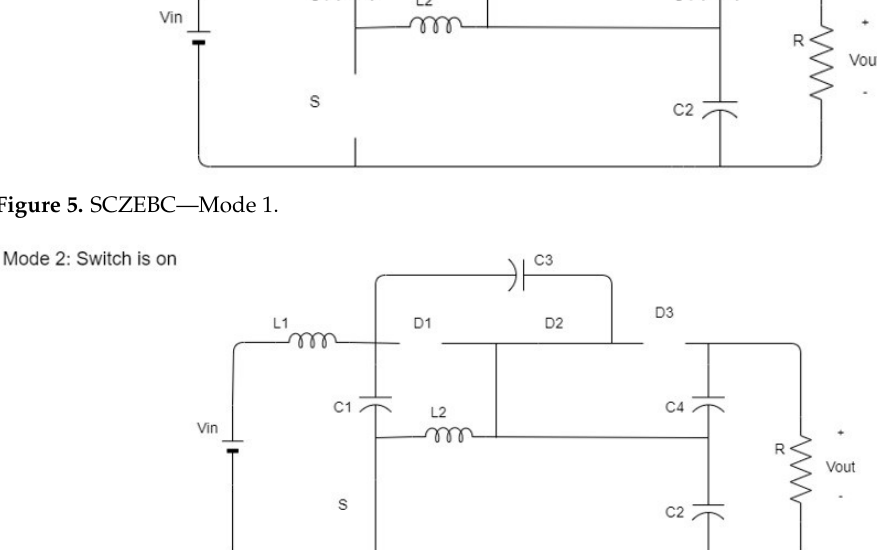
Figure 5. SCZEBC—Mode 1.